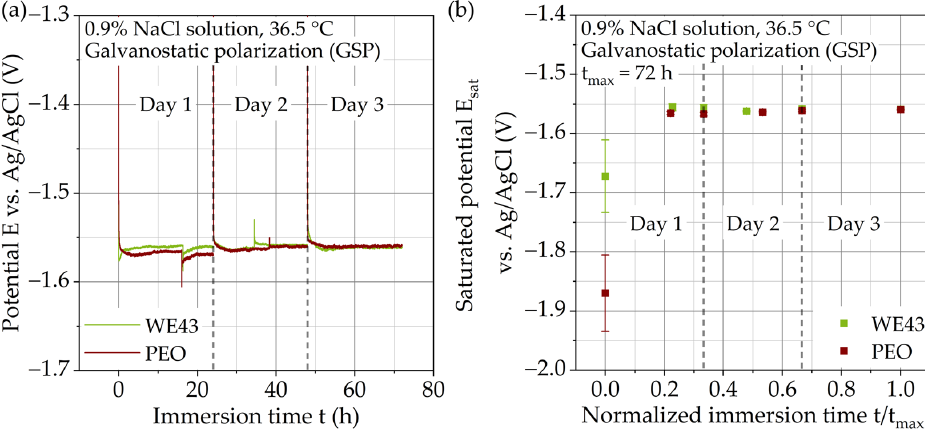
Figure 9. Immersion tests with galvanostatic polarization (GSP) on WE43 and WE43 PEO in 0.9% NaCl solution at 36.5 °C: ( a ) potential–time curves; ( b ) mean saturated potential. NaCl solution at 36.5 ◦ C: ( a ) potential–time curves; ( b ) mean saturated